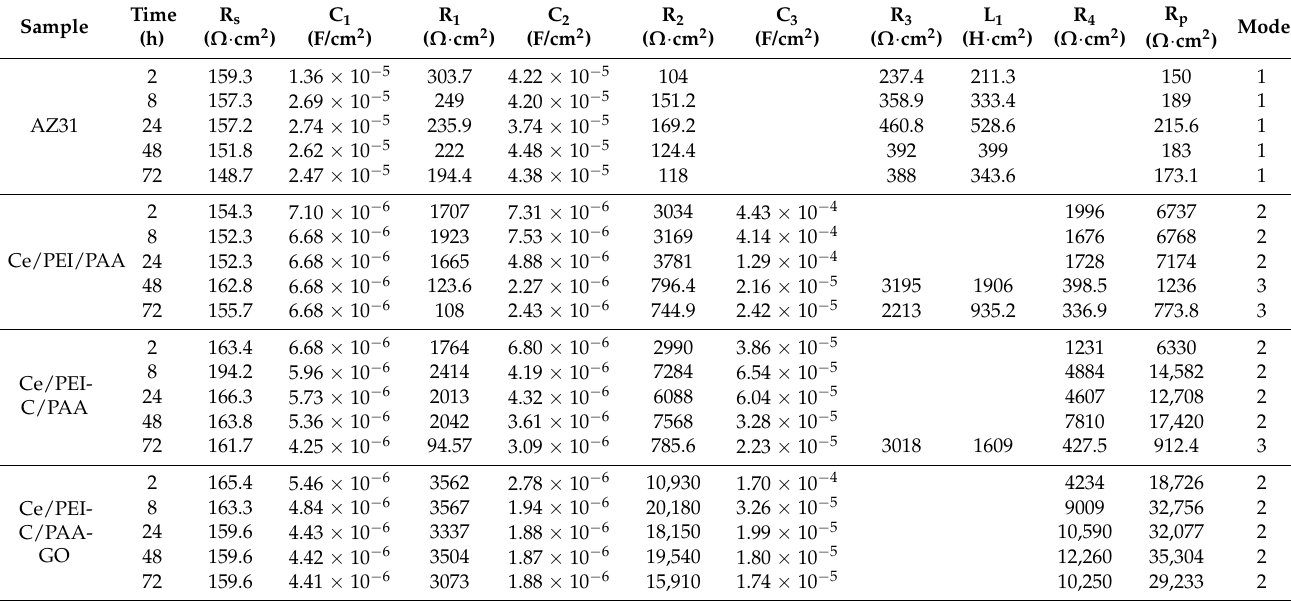
Figure 7. The variation of: ( a ) the impedance modulus (f = 0.1 Hz) and ( b ) polarization resistance with the immersion times for coated and bare AZ31B alloys of different compositions in a 3.5 wt% NaCl solution. Table 1. Electrical parameters for different coating systems immersed in a 3.5% NaCl solution; the values were obtained by fitting the EIS data.